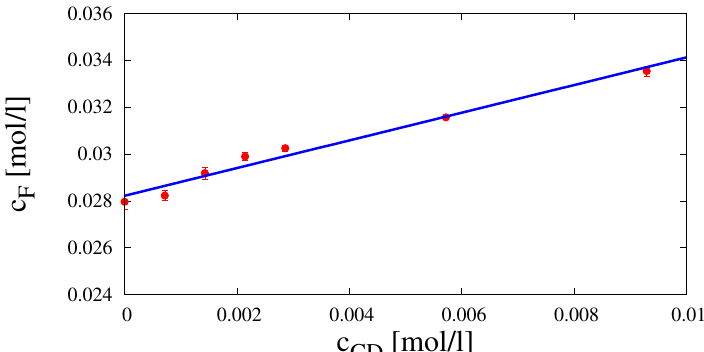
Figure 4. Phase solubility diagram of fluconazole with HP- β -CD in distilled water at T = 37 ◦